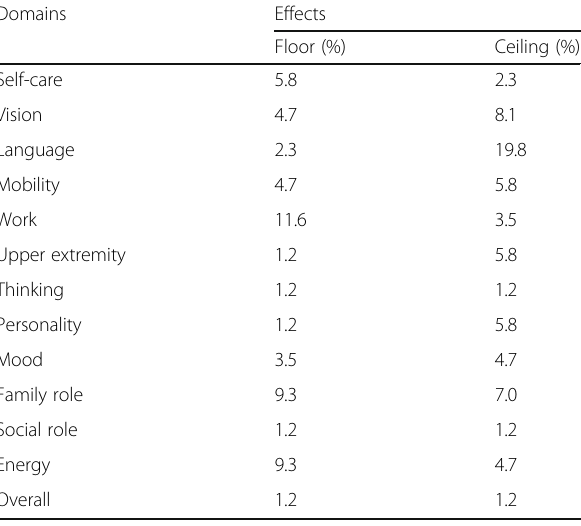
Table 11 Percentage of participants with Minimum and Maximum scores on Hausa Version of SS-QoL 2.0 scale (Floor/ Ceiling